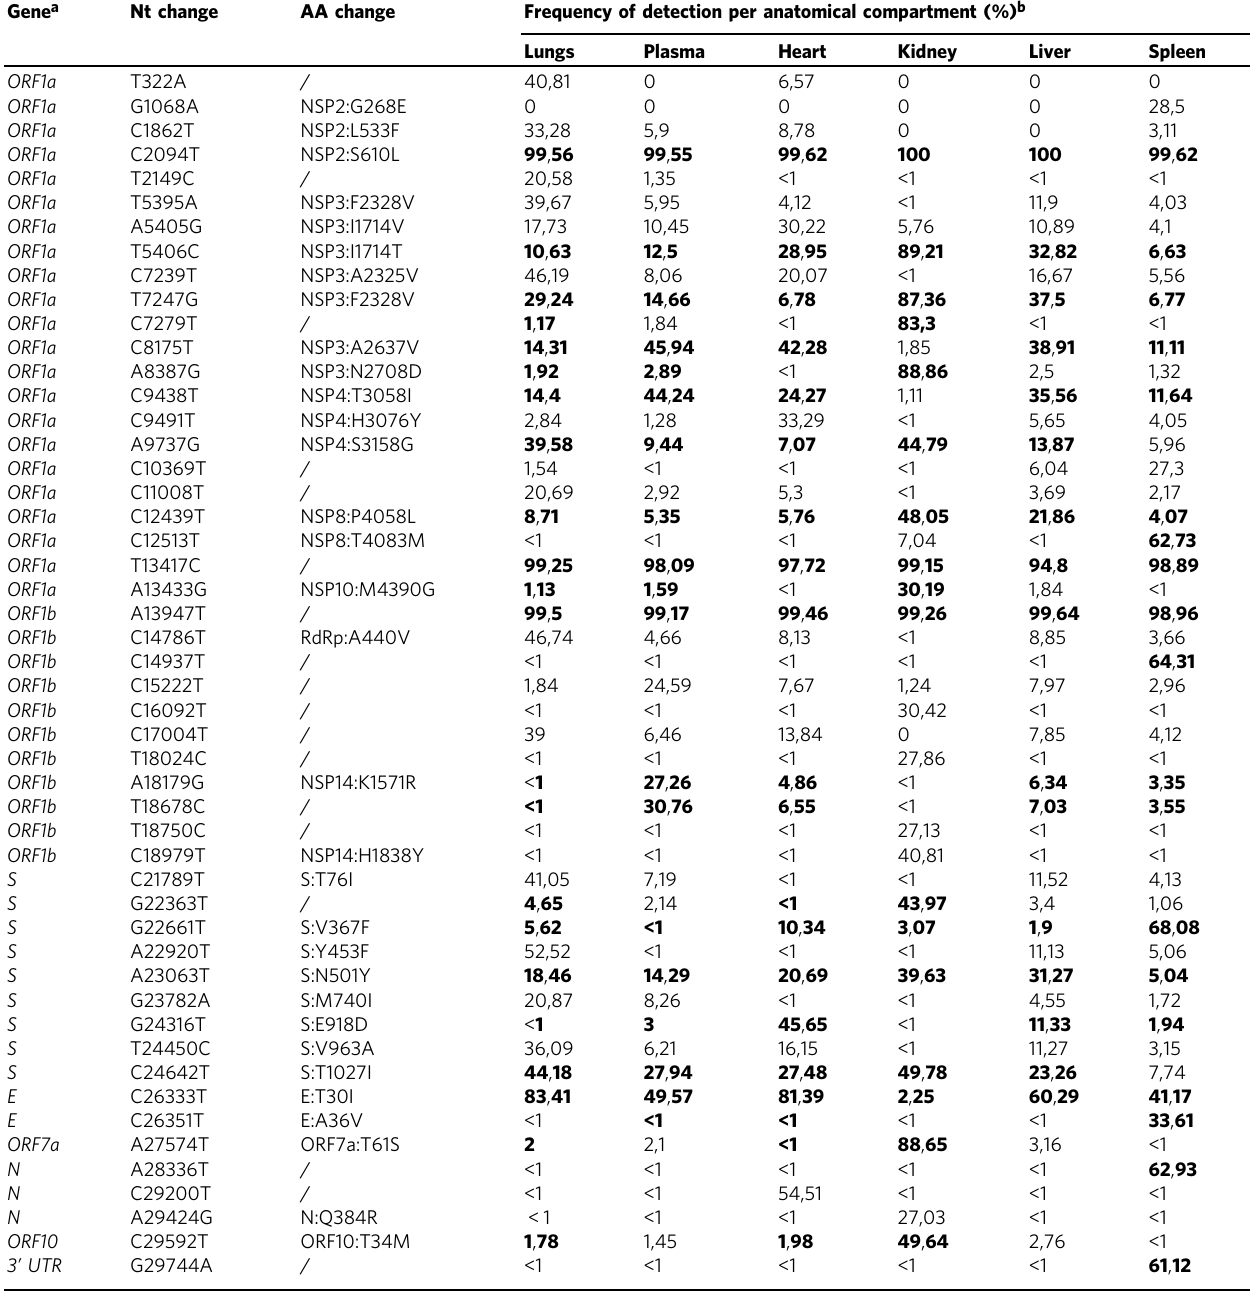
Table 1 SARS-CoV-2 genome single nucleotide variants (SNVs) in postmortem tissues and plasma of case 13. Gene a Nt change AA change Frequency of detection per anatomical compartment (%)